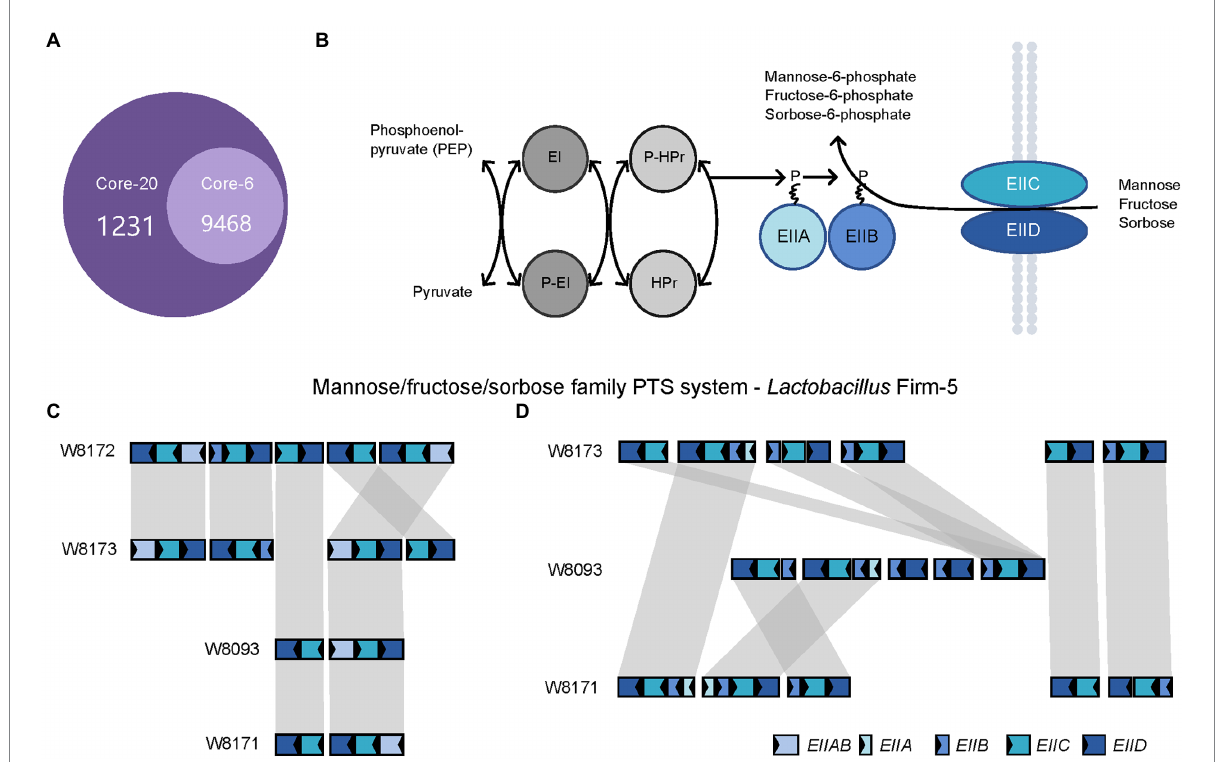
FIGURE 5 The PTS system enriched in the Core-20 community might trigger the immune response offering protection. (A) The Venn diagram was generated using OrthoVenn2. Results showed the number of shared orthologous clusters of protein-coding genes between artificial metagenomes. (B) Diagrammatic representation of the bacterial phosphotransferase signal transduction pathway (Mannose/fructose/sorbose family PTS system as an example). General phosphoryl and sugar transport reaction catalyzed by the PTS. Sugars are transported and concomitantly phosphorylated by the PTS. (C,D) In the genus Lactobacillus Firm-5, gene loci of mannose/fructose/sorbose family PTS system (C) , shared in 4 strains or (D) , unique to strains in the Core-20. Homologous genes are connected by gray bars. We found that W8173, W8093, and W8171, three stains specific to the Core-20, harbored their unique clusters of EIIA, EIIB, EIIC, and EIID, indicating that membrane-bound EII of phosphotransferase system could probably trigger an immune